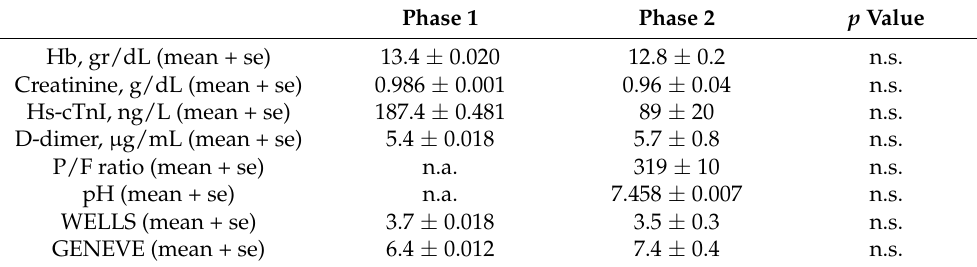
Table 3. Laboratory results.